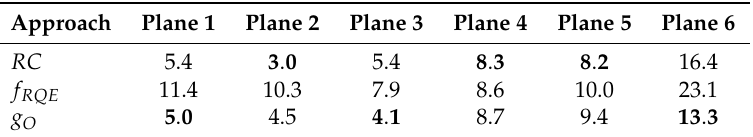
Table 3. Mean point-to-plane distances for different parts of the point cloud of the large-scale outdoor dataset (in cm). The smallest point-to-plane distance in each column is marked in bold. For three out of six planes the RC achieves the best results. For the other three planes the self-calibration based on the feature of omnivariance achieves the best